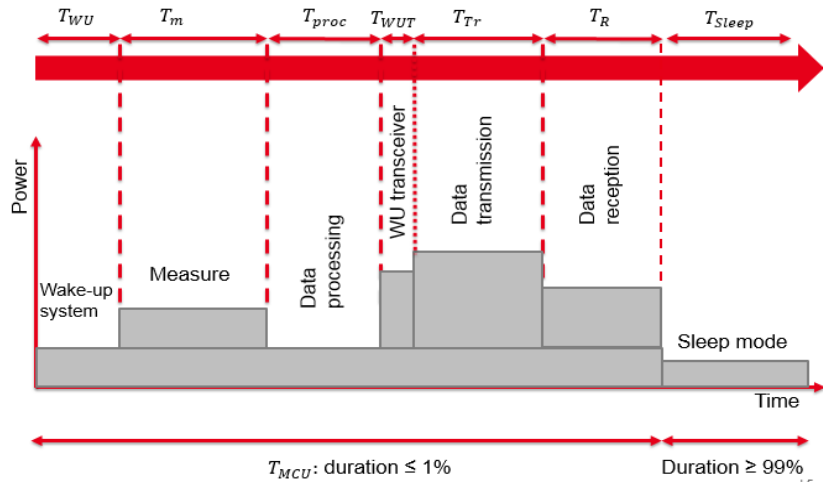
Figure 2. Sensor working